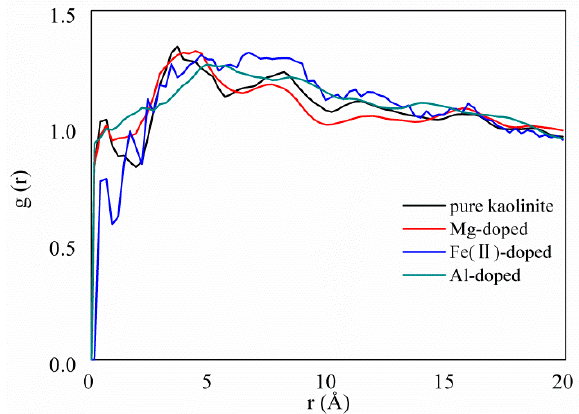
Figure 5. Radial distribution functions (RDFs) between the CH 4 and the pure, Mg-, Fe(II)-, and Al-doped kaolinite surface at 293.15 K and 20 MPa.